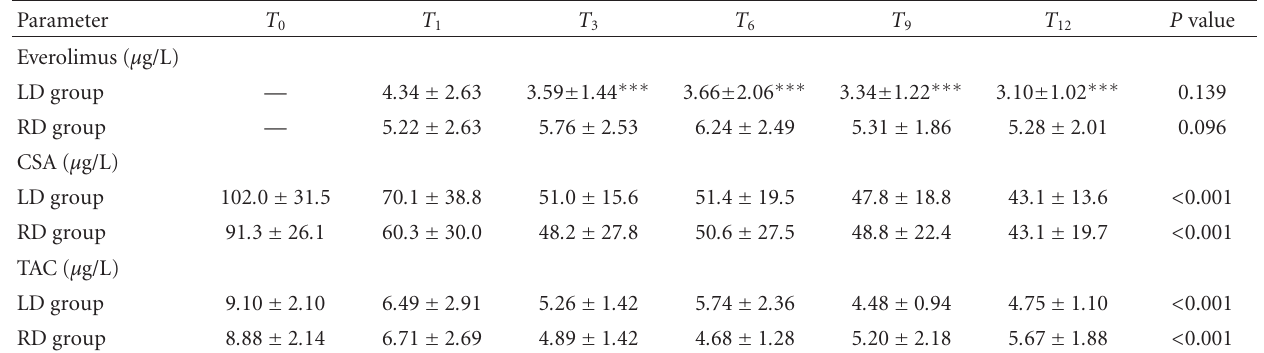
Table 2: Time course of immunosuppressive agents in cardiac transplant recipients receiving low-dose EVL (LD) or high-dose EVL (RD).